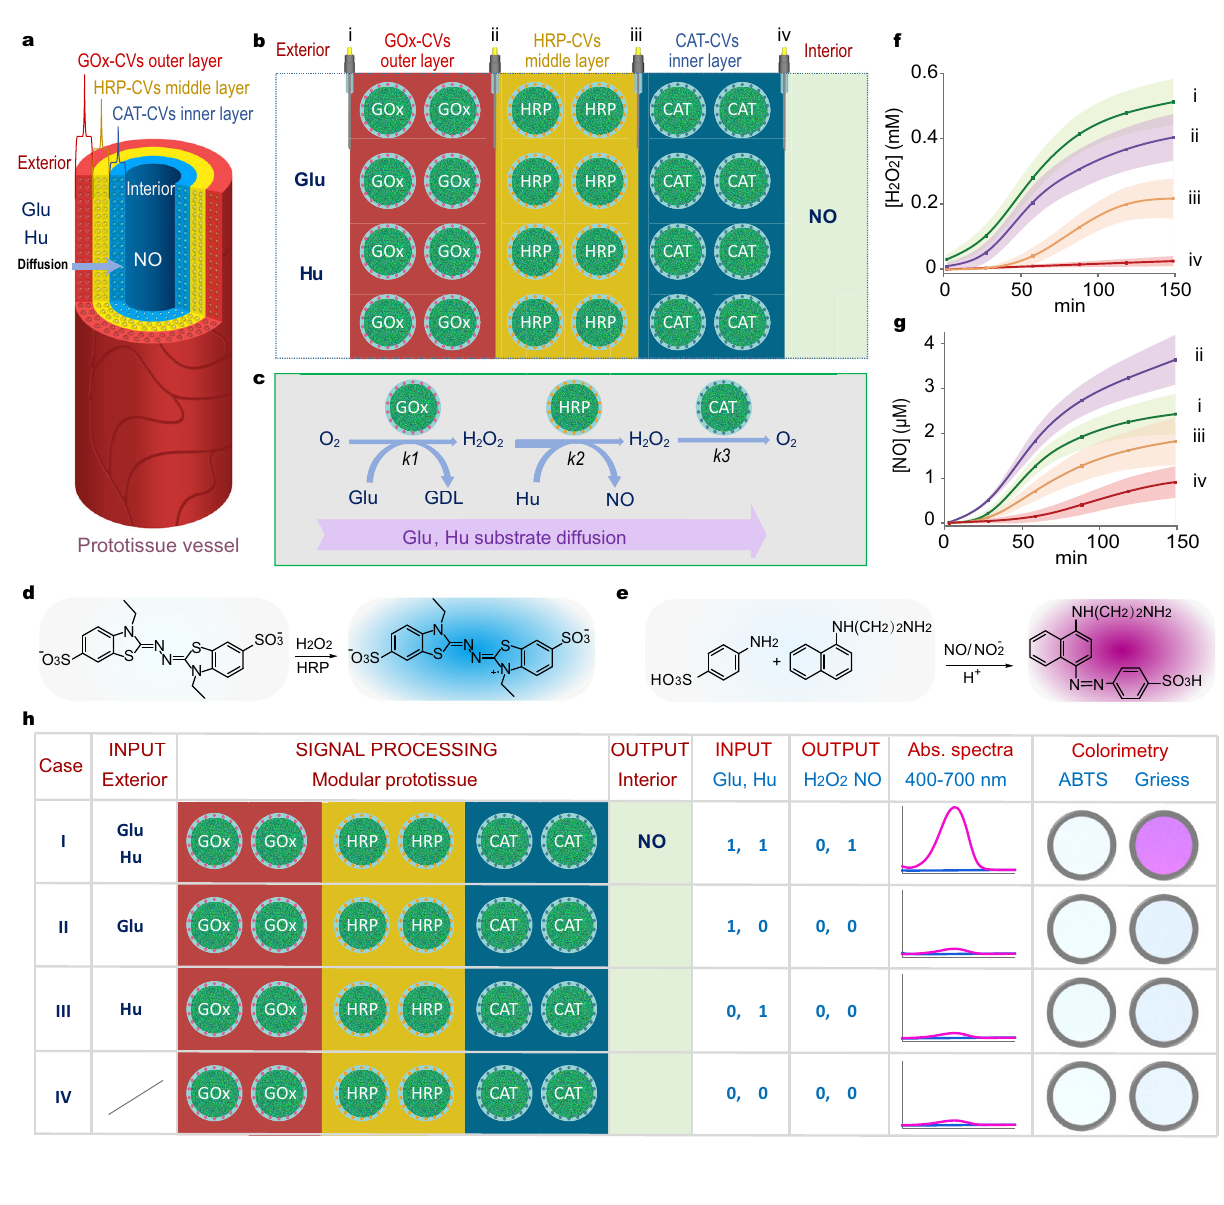
Fig. 3 | Signal processing of nitric oxide generation in a model prototissue. a Graphic showing tubular three-layer model prototissue vessel comprising immobilized populations ofGOx-CVs, HRP-CVsor CAT-CVsin the outer,middle or inner hydrogel modules, respectively. b Graphic showing a cross-section of the three-layer modular prototissue-like vessel. Generation of H 2 O 2 and NO were monitored at different positions (i – iv) using microelectrodes. c Reaction diagram for three-enzyme processing in the model prototissue vessel under reaction- diffusion conditions. H 2 O 2 generation in the outer layer serves as a diffusive signal for HRP/Hu-mediated NO production in the middle layer. Excess H 2 O 2 is removed by the CAT-CVs located in the inner layer adjacent to the lumen. Oxygen is con- sumedandproducedintheouterandinnerlayer,respectively. K1 , k2 ,and k3 arethe enzyme reaction rates for the GOx-CVs, HRP-CVs and CAT-CVs, respectively, immobilized within the different hydrogel modules. Reaction schemes for the colorimetric determinations of H 2 O 2 (HRP-mediated ABTS oxidation, d ) and NO